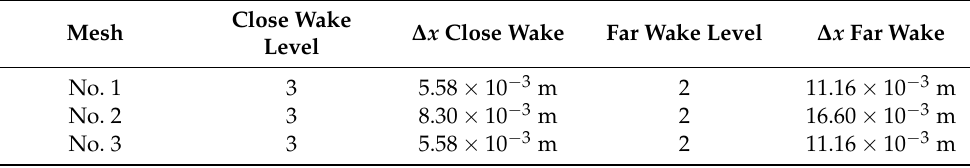
Figure 8. Mesh used in LBM-LES simulations of the tidal turbine [6]. Domain is centred at the rotor centre. ( a ): mesh No. 1 is represented in cubes of 14 × 14 × 14 nodes. ( b , c ): mesh No. 2 and 3 are represented in cubes of 16 × 16 × 16 nodes. Table 3. Mesh sizes in the wake of the